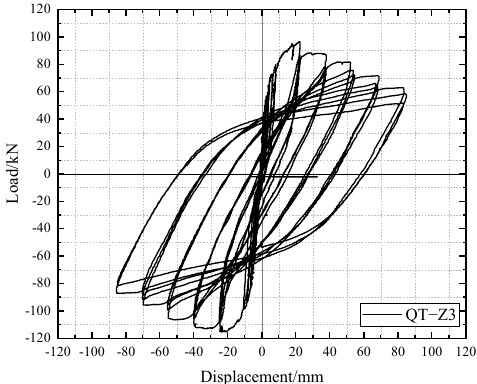
Figure 16. Load-lateral hysteresis curve of QT − Z3.